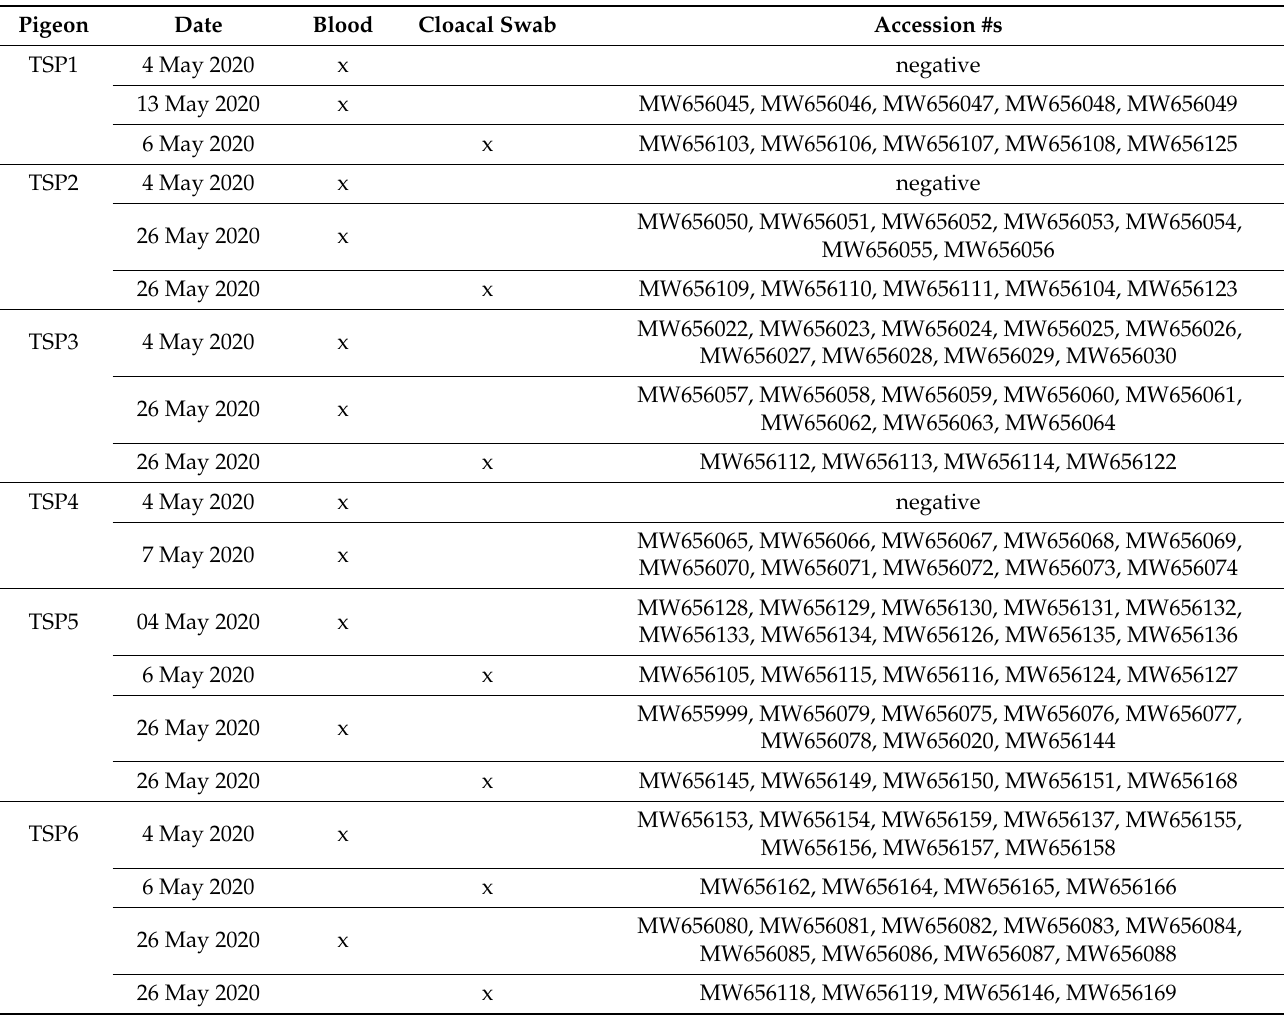
Table 1. The collection date and sampling data of PiCV genome sequences from the study. PiCV sequence accession numbers and the number of isolates from samples are listed.